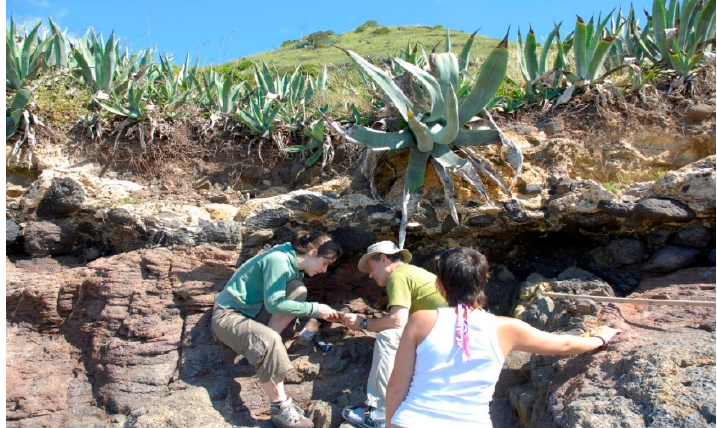
Figure 2. Modern coastal boulder deposit (CBD) eroded from adjacent basalt sea cliffs at Prainha (site 1). Note that some boulders on the far inland end of the littoral boulder cordon were embedded within the sand.